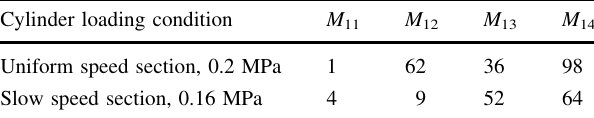
Table 7 Feature values of local resistance over-limit points of closing doors